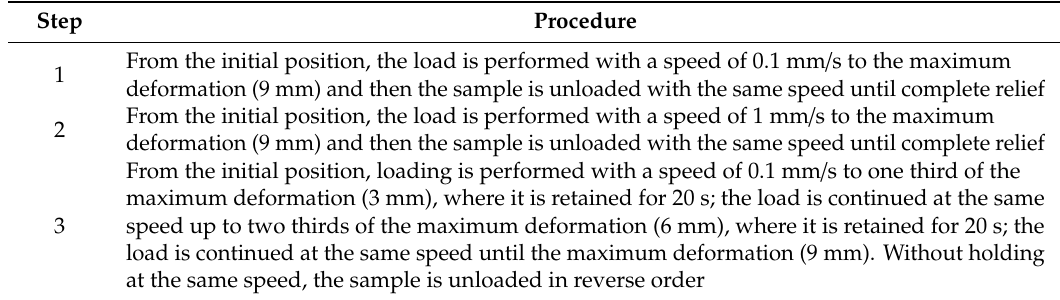
Table 5. Test procedure for rubber